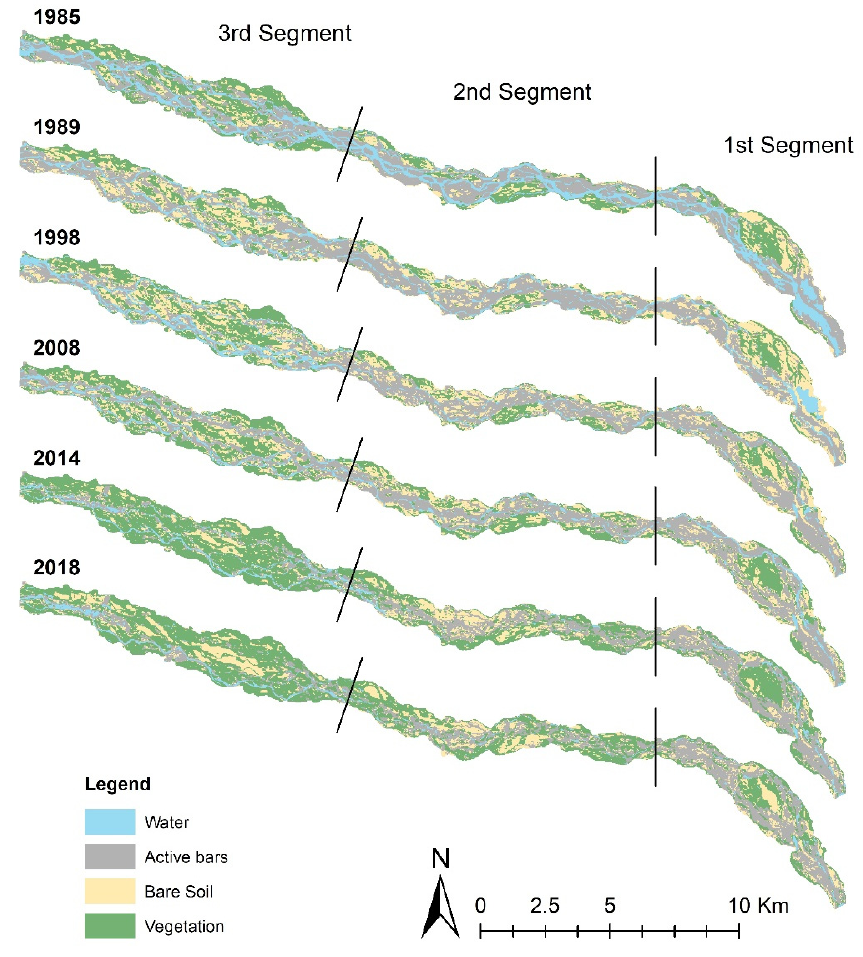
Figure 4. Land cover for the middle section of the Maule River, 1985–2018. Table 5. Area per land